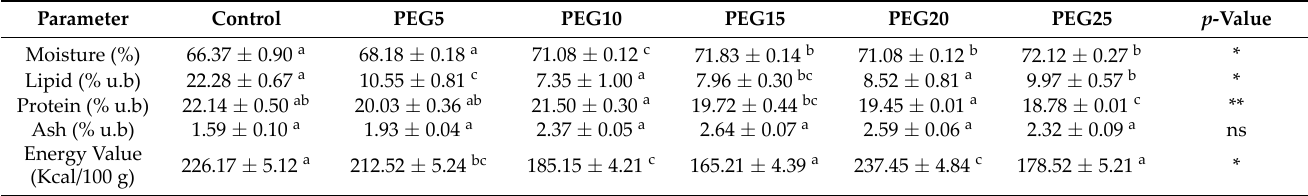
Table 2. Semi‑smoked sausages’ proximate composition formulated with horsemeat and different level of emulsion gel.